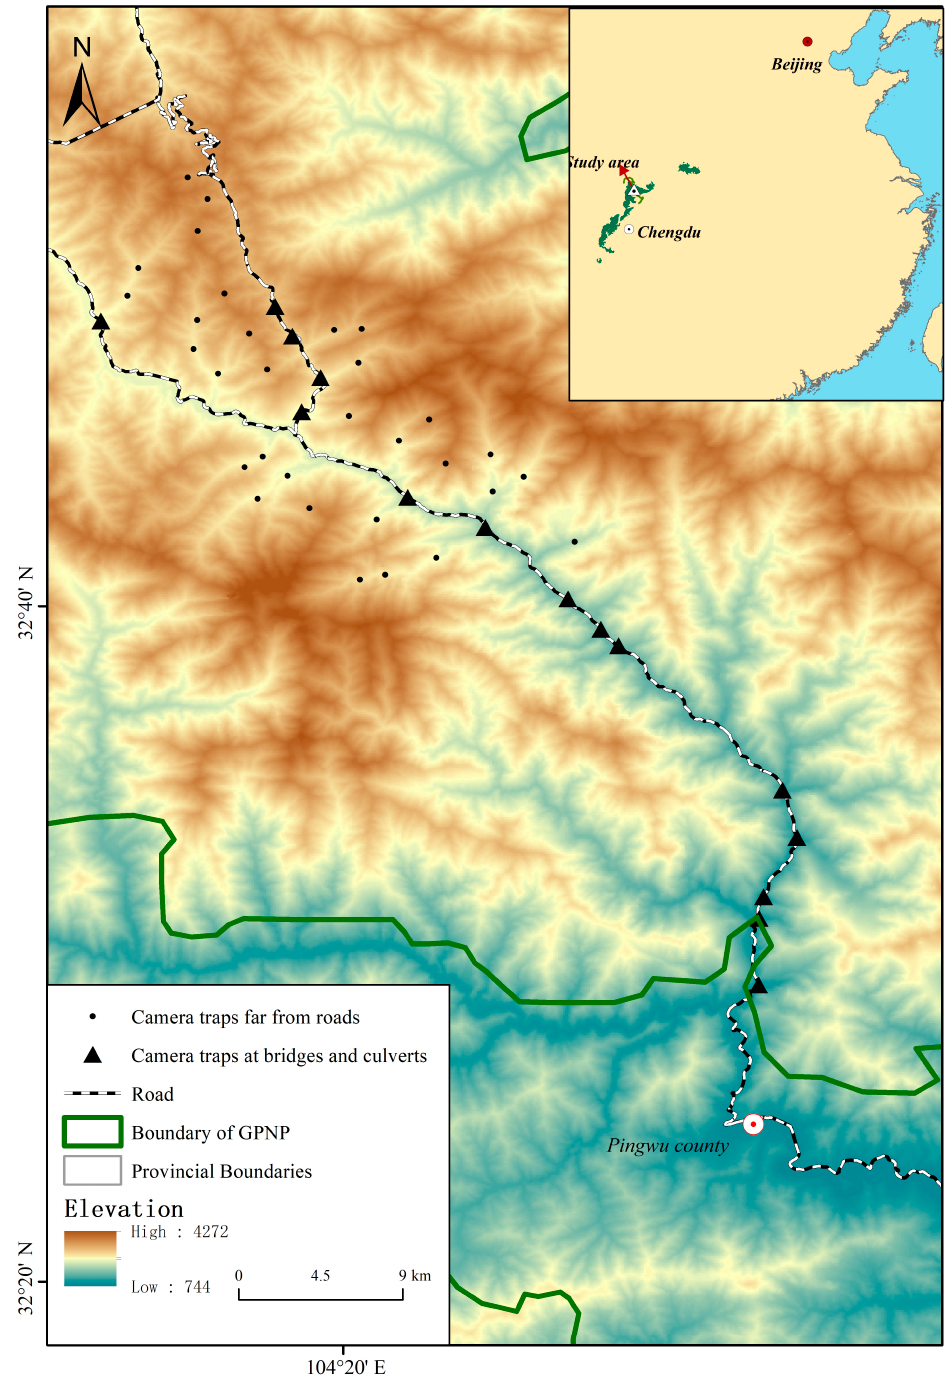
Figure 1. Study area in Pingwu county, north of Giant Panda National Park, Sichuan, China.